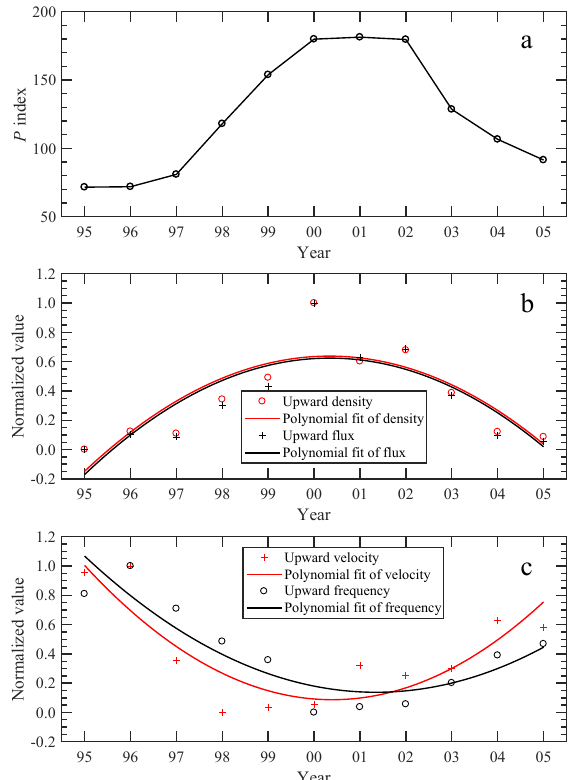
Figure 4. Spatial distribution of relative deviation: (a) ion upflow density, (b) ion upflow flux, (c) ion upward velocity, and (d) upflow occurrence frequency. The average time period is from March 1996 to December 2005.